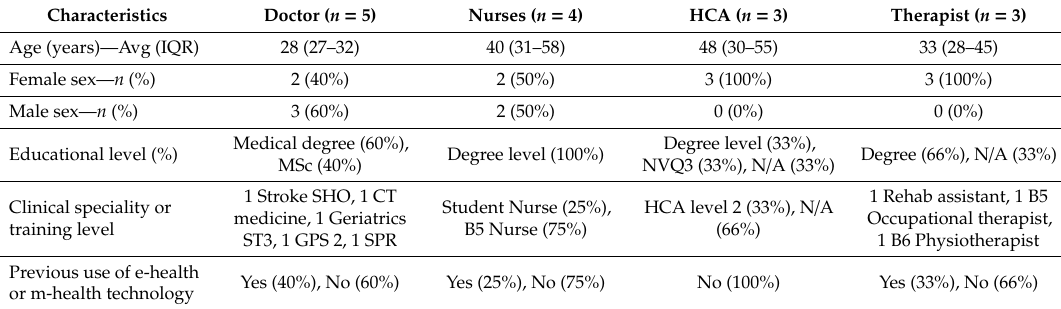
Table A3. Healthcare professional characteristics ( n = 15).